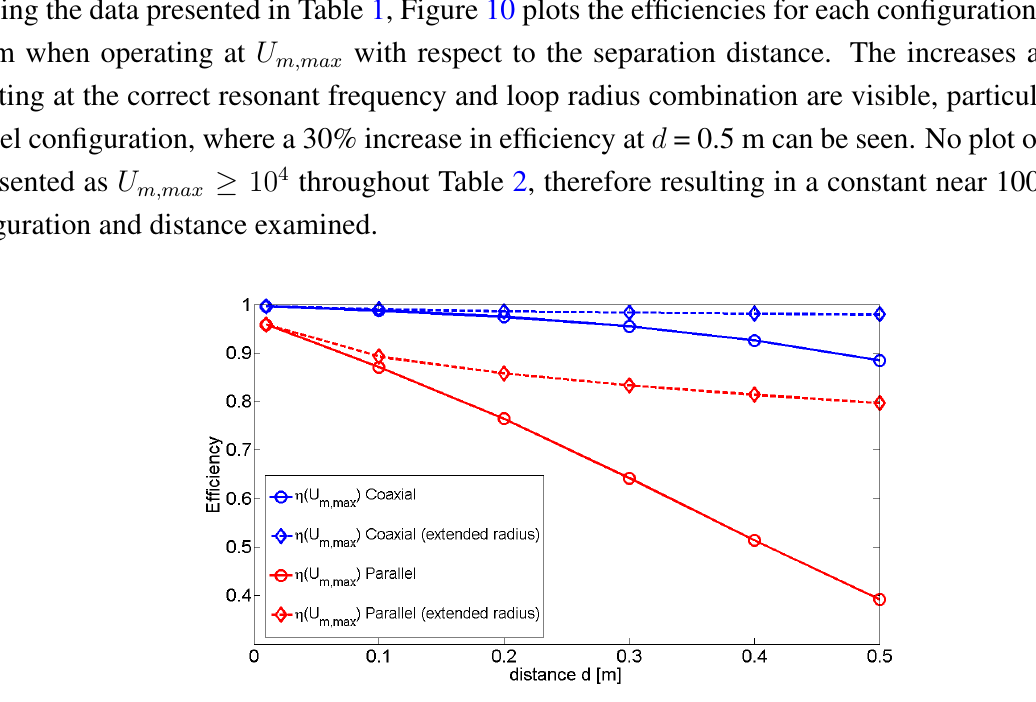
for l = 2 a = 0.3 m. 0